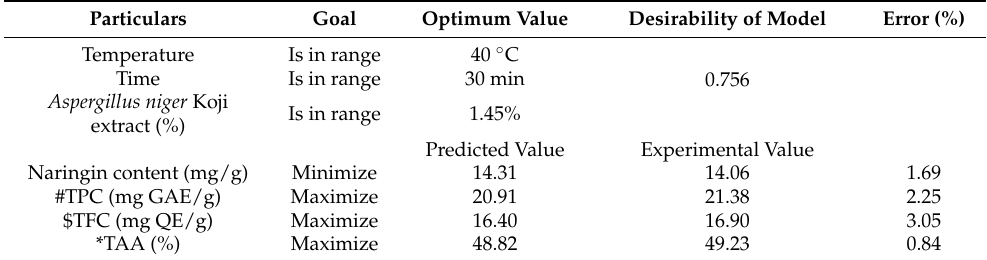
Figure 5. Three-dimensional response surface plots for TAA as affected by processing parameters ( a – c ). Table 5. Predicted and experimental values of dependent